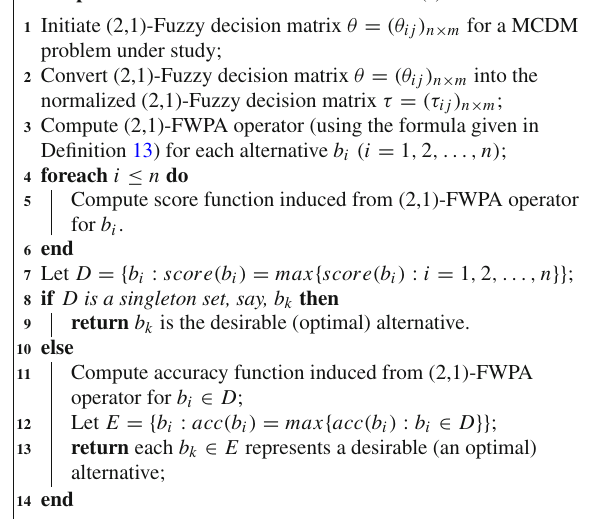
Algorithm 3: The algorithm of selection the optimal alternative(s) with respect to (2,1)-FWPA operator